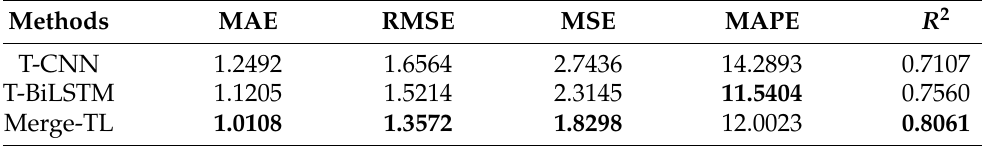
Table 5. Results of the 2 h prediction for the site S8.